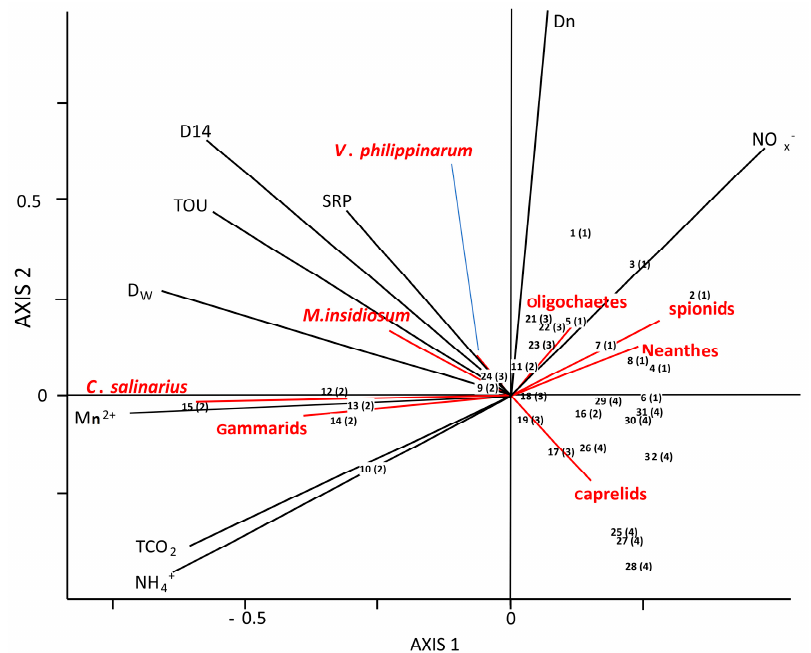
Figure 6. Distance triplot of redundancy analysis (RDA) on fluxes (TOU; TCO 2 , Mn 2 + , NH 4 + , NO X − , and SRP) and processes (denitrification—D14, Dw, and Dn) in the Sacca di Goro Lagoon, using the eight most representative benthic macrofauna as explanatory variables ( V. philippinarum , Neanthes, spionids, oligochaetes , C. salinarius, M. insidosum, gammarids, and caprelids). Numbers (1–32) indicate single cores collected from the four sampling sites. The thick arrows are the vectors of the explanatory variables. The projection of any sample onto arrows approximates the measured value in that sample.